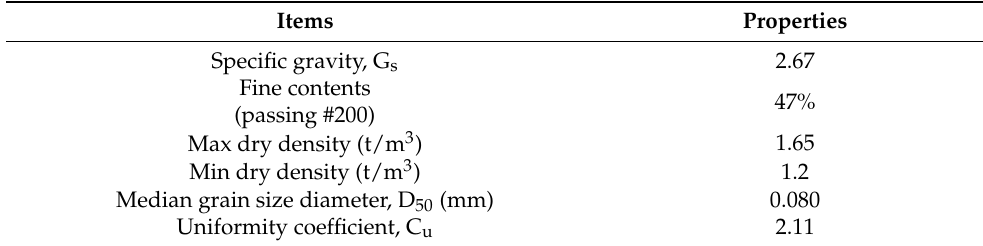
Table 2. Basic soil properties of Semanguem sand .